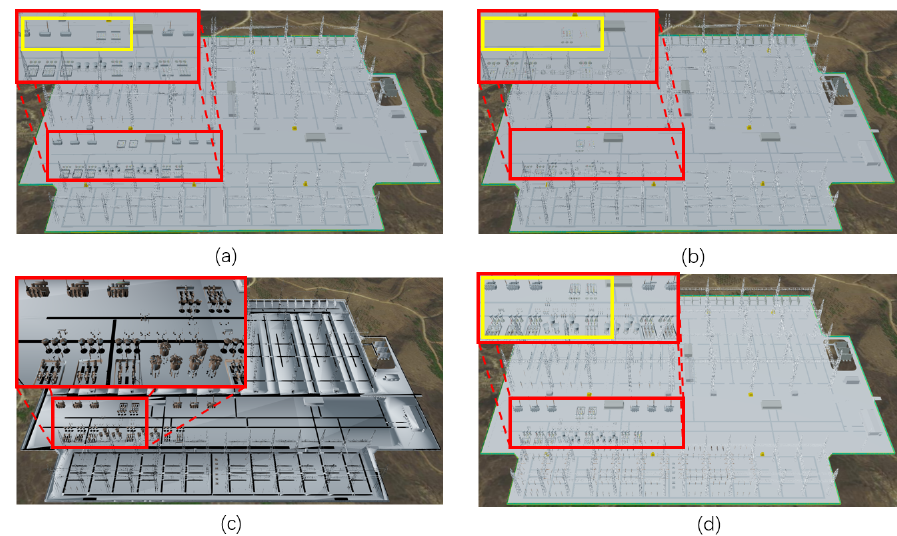
Figure 9. Model visualization at a viewing distance of 300 m when using: ( a ) proposed method, ( b ) Method 1, ( c ) Method 2, and ( d ) Method 3.